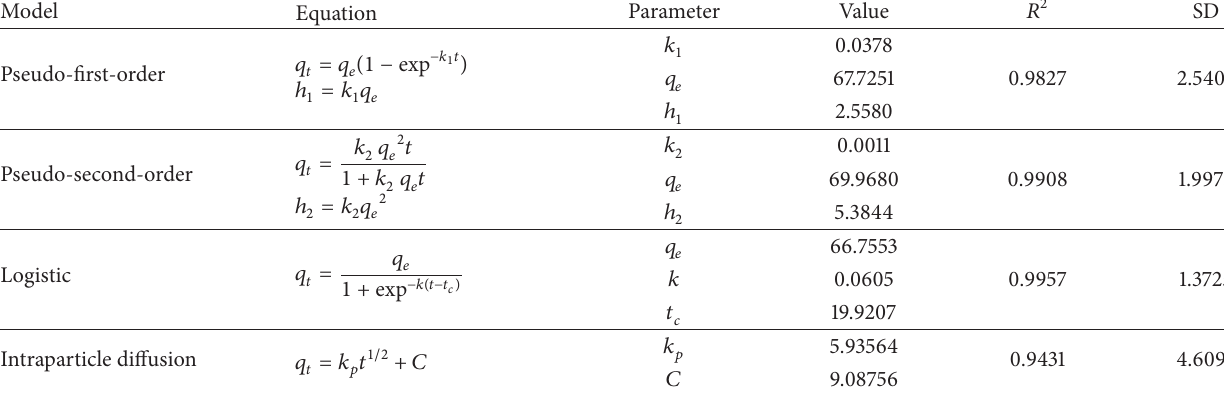
Table 6: Kinetic parameters of dye removal.